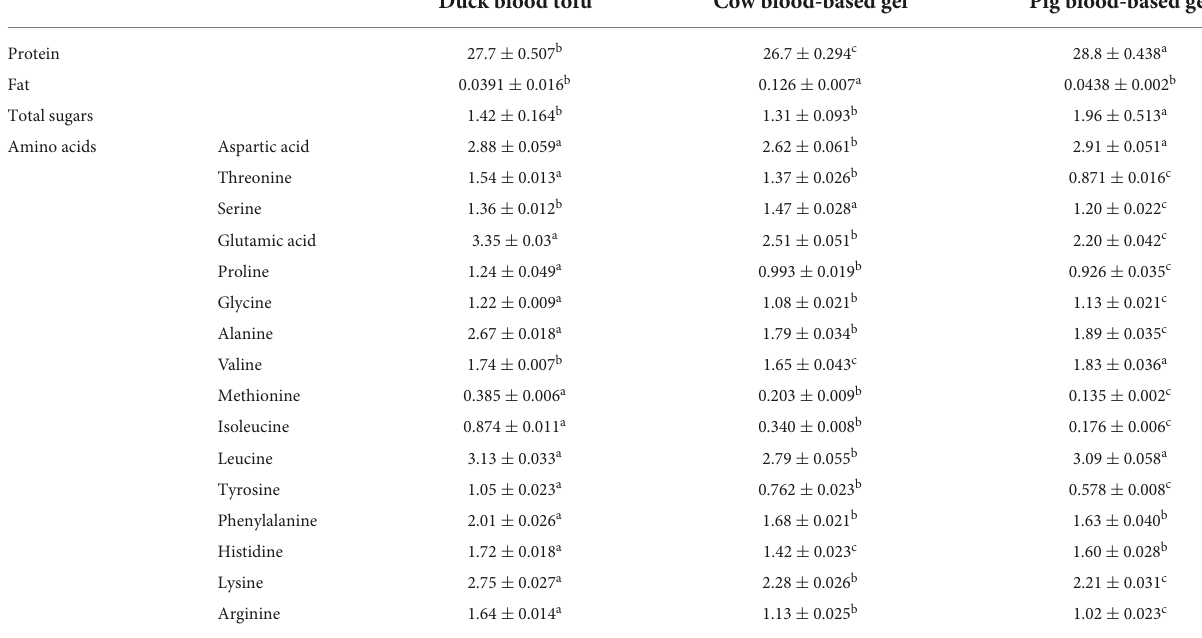
TABLE 2 Protein, fat, total sugars, and 16 different amino acids content (g/100 g) in the raw duck blood tofu, cow, and pig blood-based gels used. Duck blood tofu Cow blood-based gel Pig blood-based gel Protein